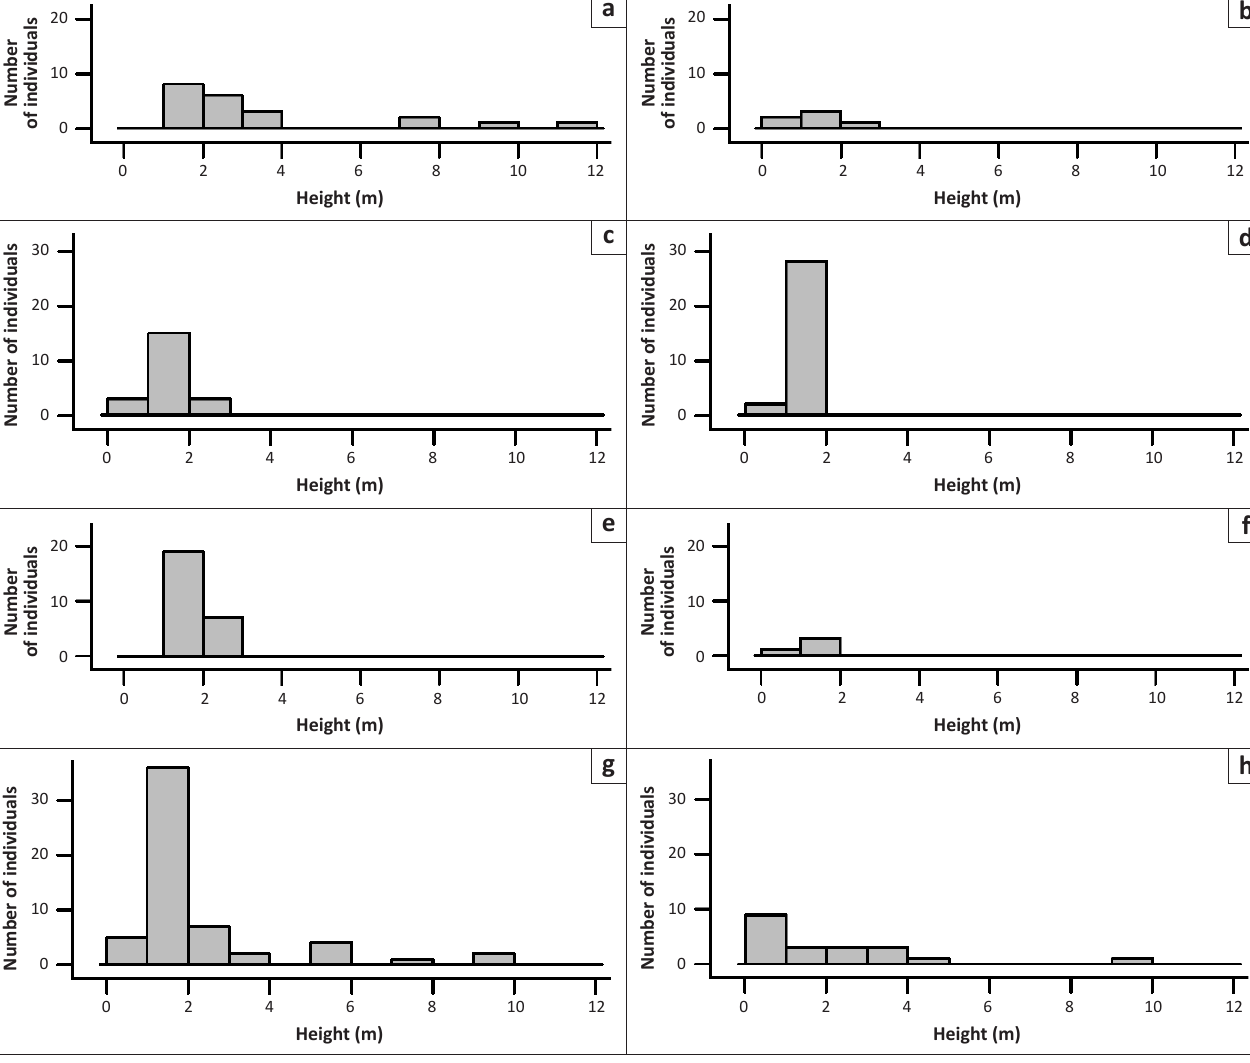
FIGURE 4: Size class distributions of Lannea schweinfurthii populations growing (a) inside and (b) outside, Gymnosporia senegalensis populations growing (c) inside and (d) outside, Flueggea virosa populations growing (e) inside and (f) outside and Acacia nigrescens populations growing (g) inside and (h) outside of the Makhohlola exclosure in the Kruger National